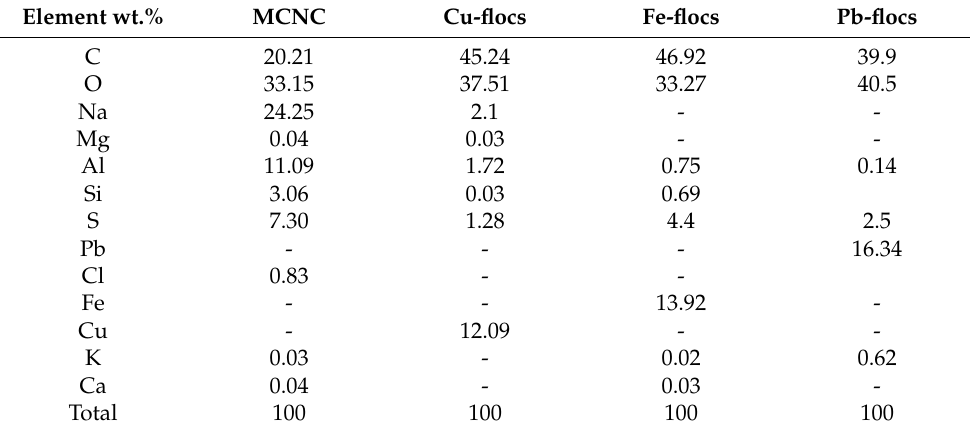
Table 1. EDS analysis of MCNC, and floccules formed during the coagulation process.